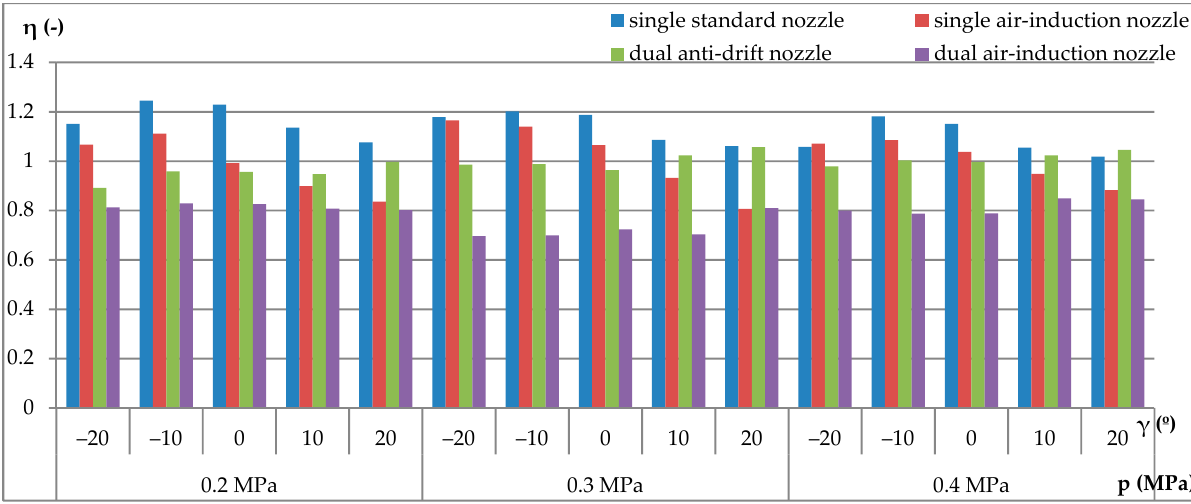
Figure 7. Coverage unevenness coefficient for selected nozzles at 3.3 m ∙ s − 1 driving speed.